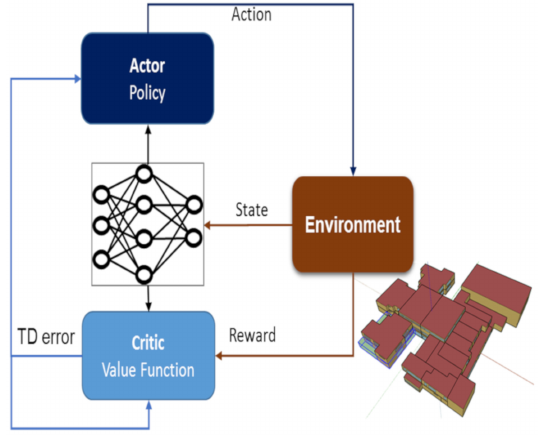
Figure 2. Actor–critic